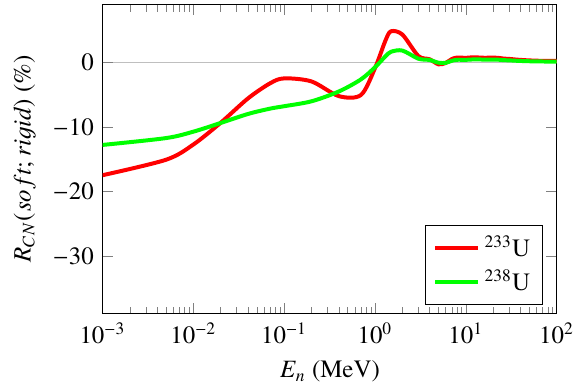
Figure 4. Change of CN formation cross section due to truncation of the full coupling scheme: some or all non-GS bands are removed.